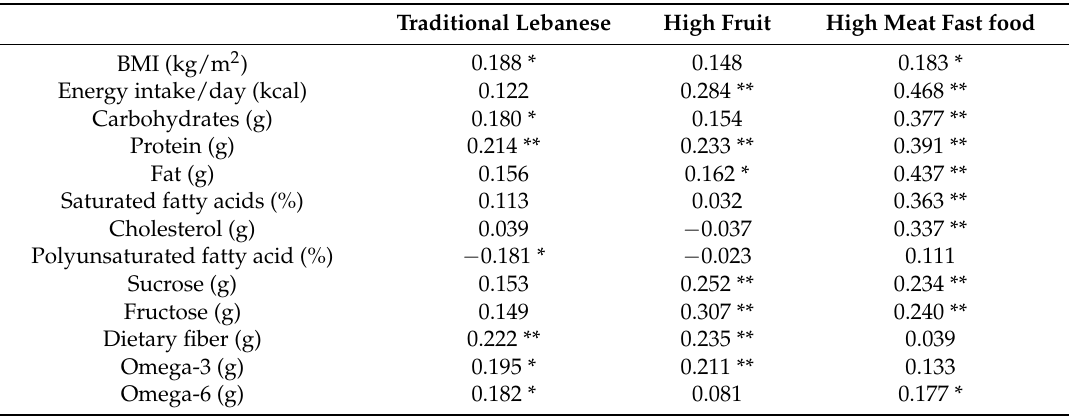
Table 5. Spearman’s correlation coefficient between pattern scores and anthropometric measurements, nutrients, and total energy intake.